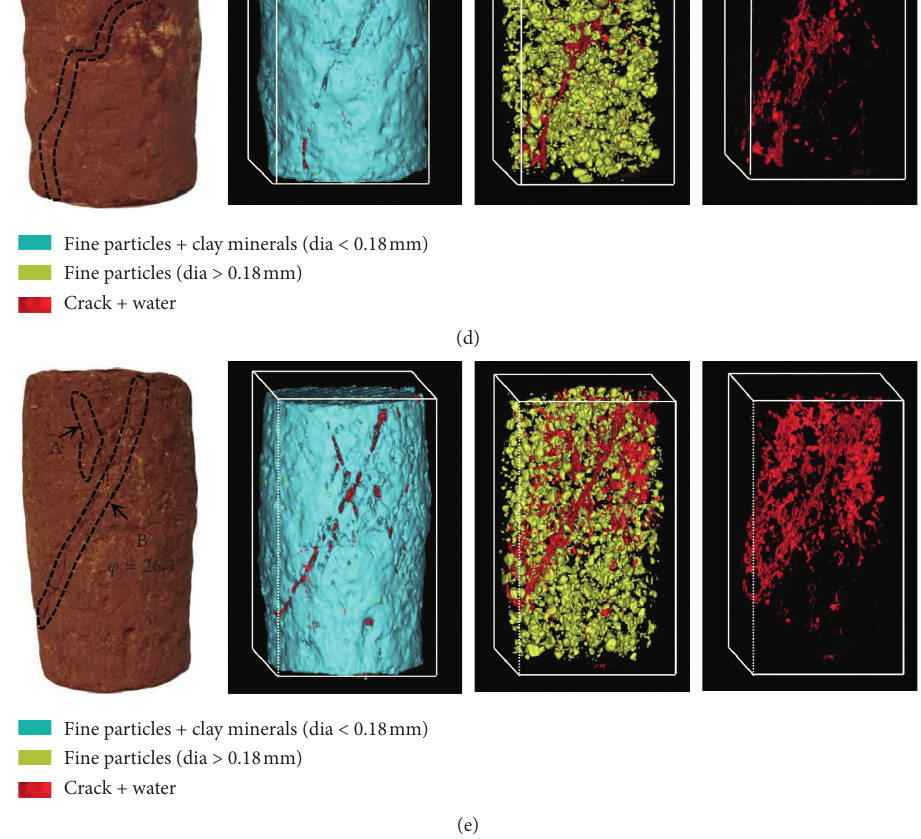
Figure 8: Schematic diagram of crack propagation after a two-stage loading process. (a) Intact soil column ε � 0%. (b) σ